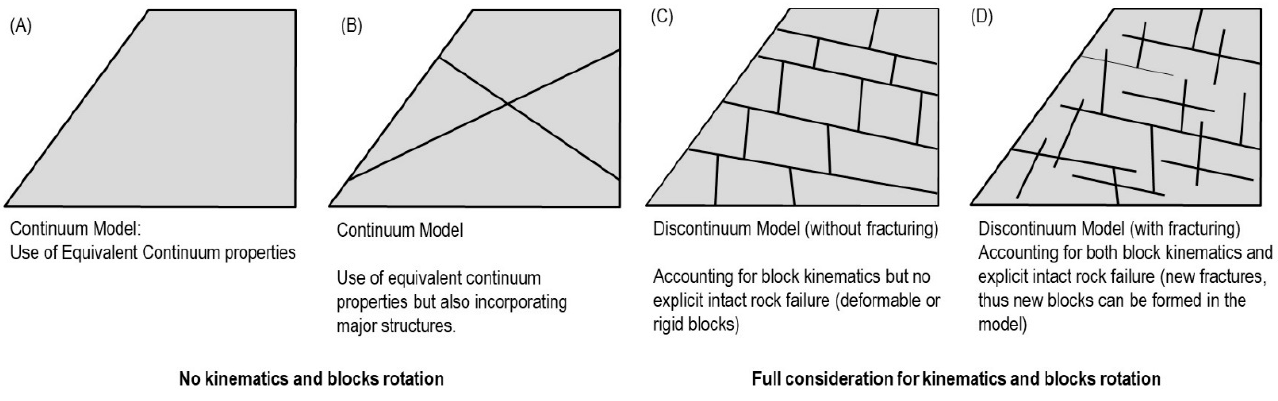
Figure 3. Example of how continuum modelling trades structural complexity (inserts C and D ) for geometrical simplicity (inserts A and B ).